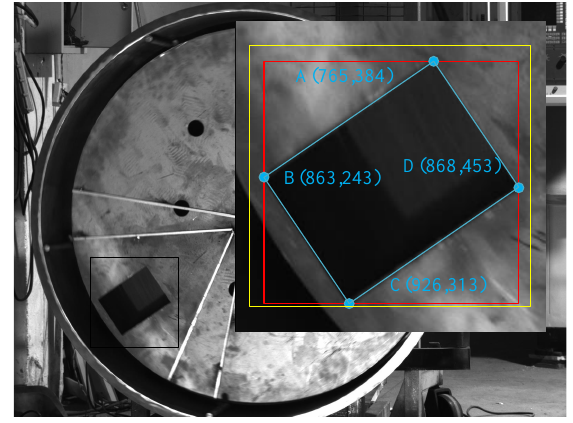
Figure 5. The MBR and counter of the